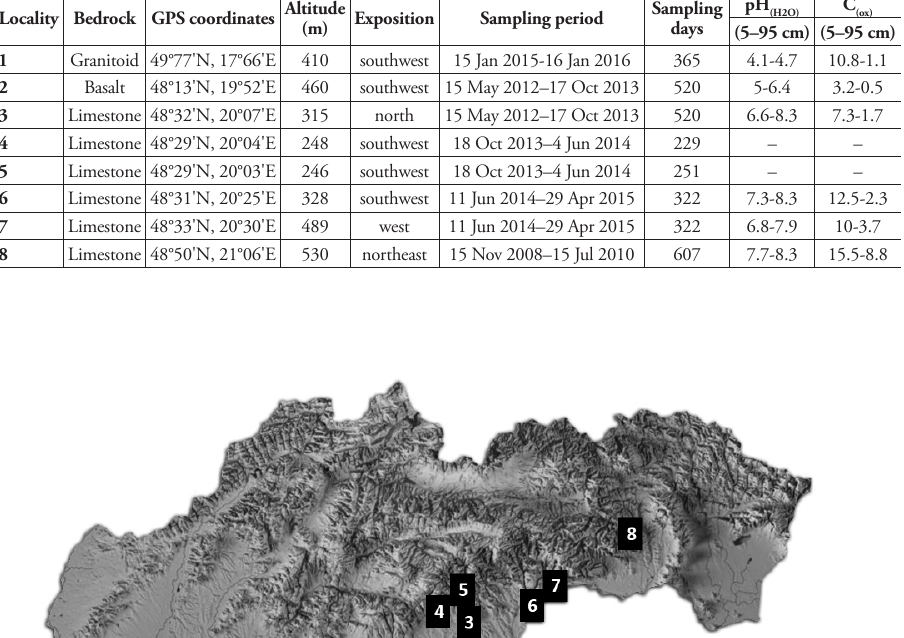
and C values, both after Rendoš et al. (H20) (ox)